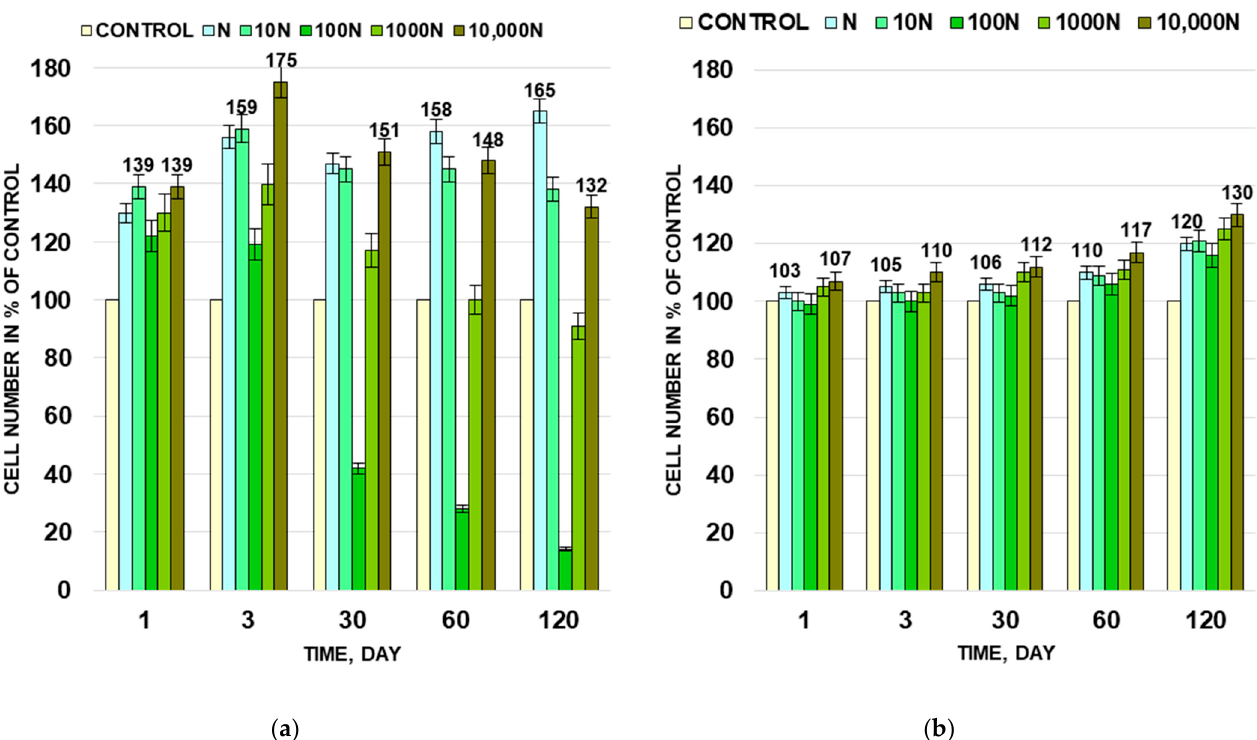
Figure 2. The effect of BNP on the cell number of M. luteus ( a ) and A. faecalis ( b ) in experimental populations in exponential (1 day) and stationary (3 days) growth phases and in long-term storage (30, 60, and 120